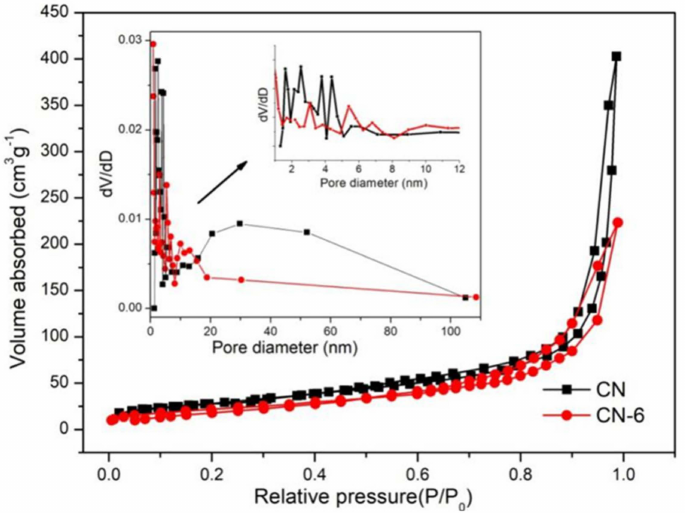
Figure 5. Adsorption–desorption isotherm of CN and